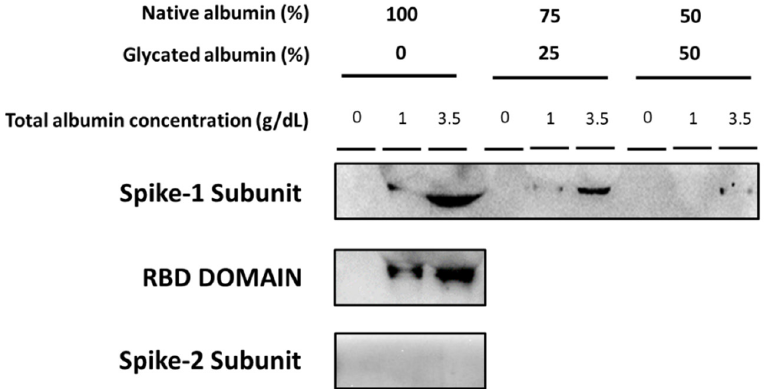
Figure 4. Binding ability of COVID-19 spike subunits to native and glycated albumin in vitro. Representative Western blots show the binding of recombinant SARS-CoV-2 spike protein S1 subunit to 1 g/dL and 3.5 g/dL native albumin. Experiments where each final albumin concentration of native albumin (1 g/dL and 3.5 g/dL) was replaced by glycated albumin (25% and 50%) are also represented. The figure also shows a representative Western blot showing the binding of native albumin (1 g/dL and 3.5 g/dL) to the recombinant receptor-binding region, RBD, of the SARS-CoV-2 spike protein contained in the S1 subunit. The spike protein S2 subunit failed to bind to 1 g/dL and 3.5 g/dL albumin.